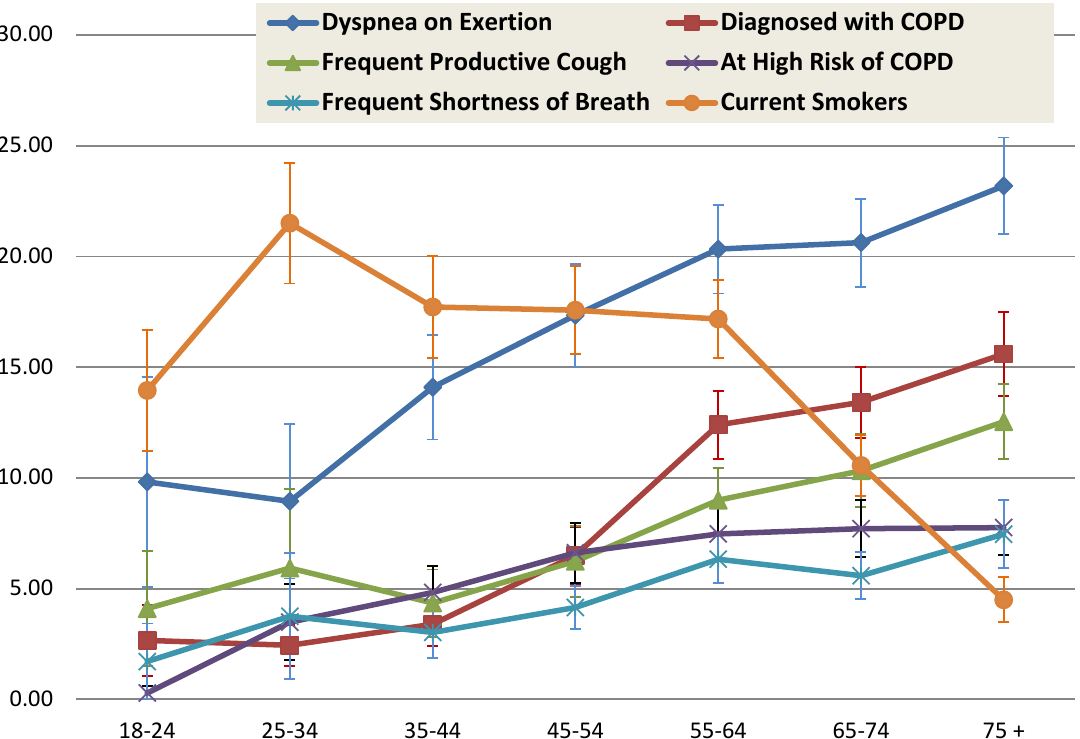
Figure 1. Age group specific prevalence of respiratory symptoms, current smoking, and COPD risk in adults ≥ 18 years-old using the 2015 Behavioral Risk Factor Surveillance System telephone survey in four states (FL, KY, SC, TX).